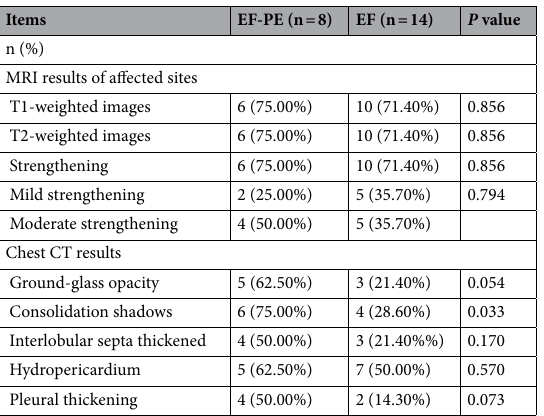
Table 6. MRI and chest CT examination results of the affected sites in both groups. Comparisons were determined by chi-square test or Fisher’s exact test. P < 0.05 was considered statistically significant. CT computed tomography, MRI magnetic resonance imaging.